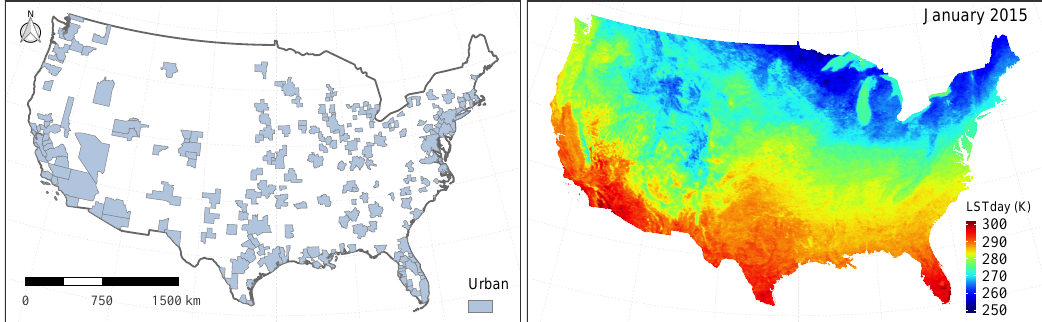
Figure 2. ( left ) Urban areas in the conterminous United States, accessed from OECD. ( right ) The monthly daytime land surface temperature (LSTday) in January 2015, accessed from LAADS data